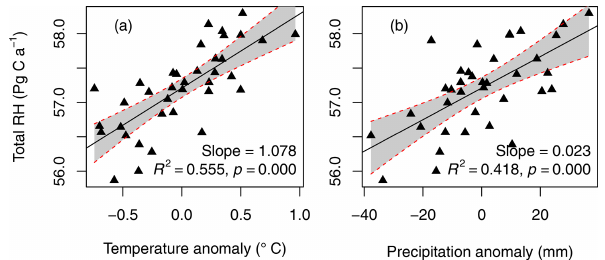
Figure 6. The relationships between heterotrophic respiration (RH) and mean annual temperature (a) or precipitation anomalies (b) . The change was calculated as the difference of each given year to the average over 1980 to 2016. Grey areas indicate 95% confidence